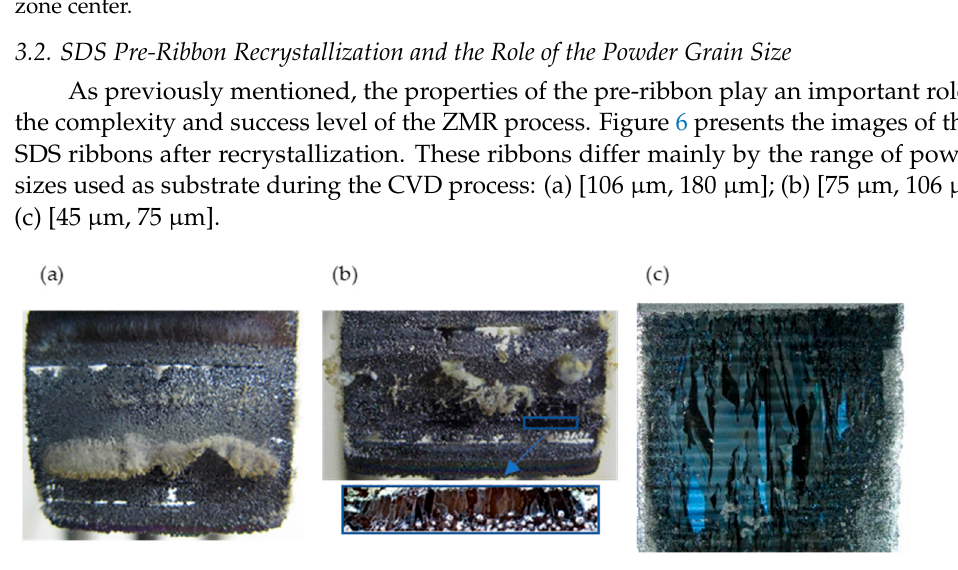
Figure 6. SDS samples after ZMR: ( a ) [106 µm, 180 µm]; ( b ) [75 µm, 106 µm]; ( c ) [45 µm, 75 µm]. Note: Ribbon width is 25 mm.